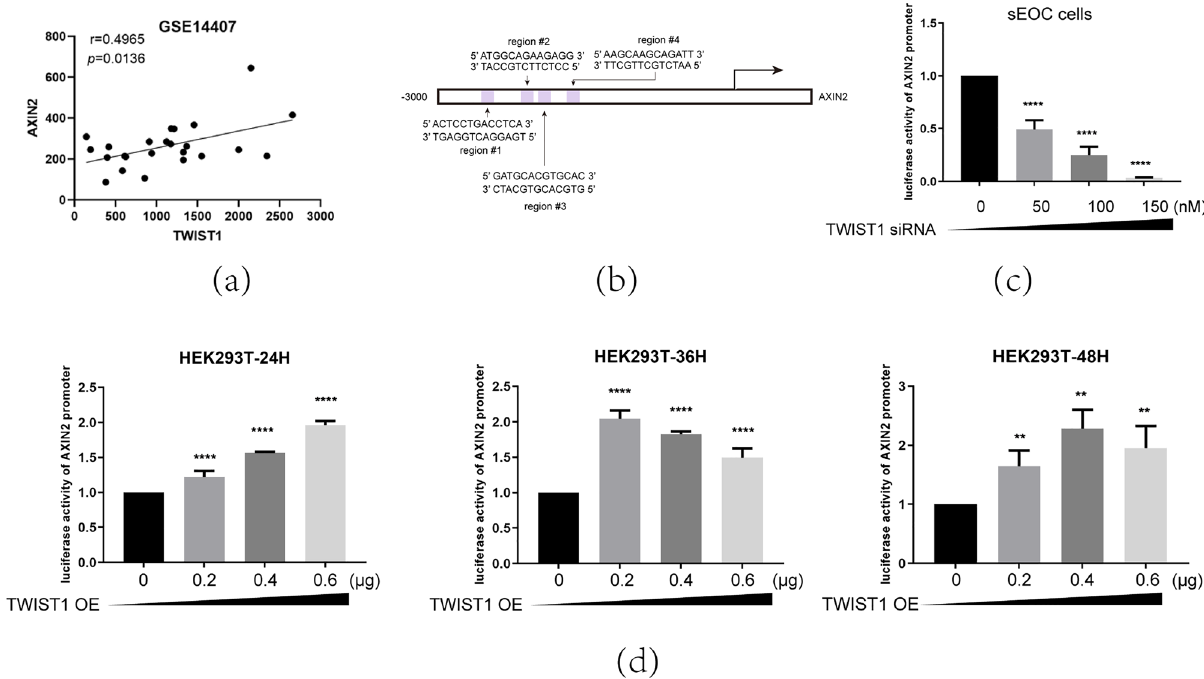
Figure 4. TWIST1 directly binds to Axin2. ( a )Spearman correlation analysis of mRNA level of Twist1 and Axin2 levels in OC stem cells(n = 24). ( b )The schematic structures of Twist1 putative binding sites in the AXIN2 promoter in EPD (https:// epd. epfl. ch/). ( c )Promoter luciferase reporter assays of Axin2 in sEOC cells with TWIST1 knockdown (siTwist1, + 50 nM, + + 100 nM, + + + + 150 nM). **** p ,** p < 0.05, Student’s t test. ( d ) Promoter luciferase reporter assays of Axin2 in normal epithelial cells with TWIST1 overexpressed, oeTWIST1 by transfecting PCMV-SPORT6-Twist1 (oe TWIST1: 0.2 μg/per 24 well, 0.4 μg/per 24 well, 0.6 μg/per 24 well). **** p ,** p < 0.05, Student’s t